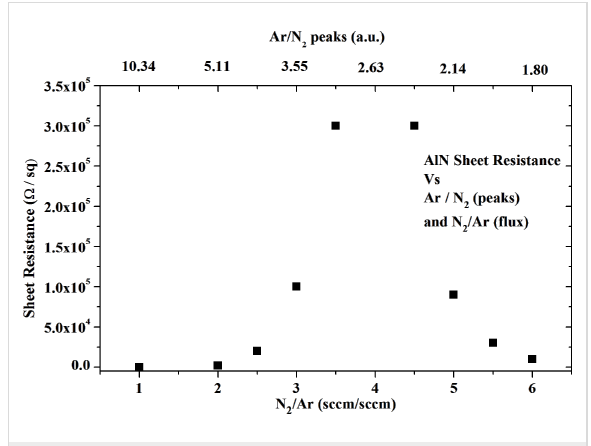
Figure 6: Resistivity of AlN film as a function of N 2 /Ar gas flux and Ar/N 2 peak ratio. The rf power was fixed at 150 W.